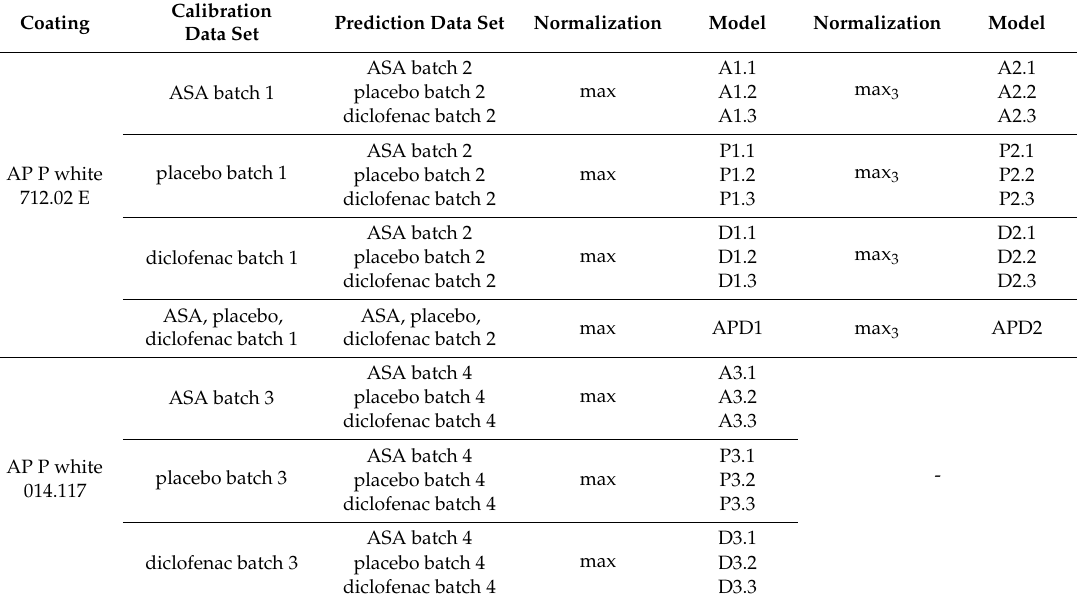
Table 2. Data selection for model building and testing for both coating